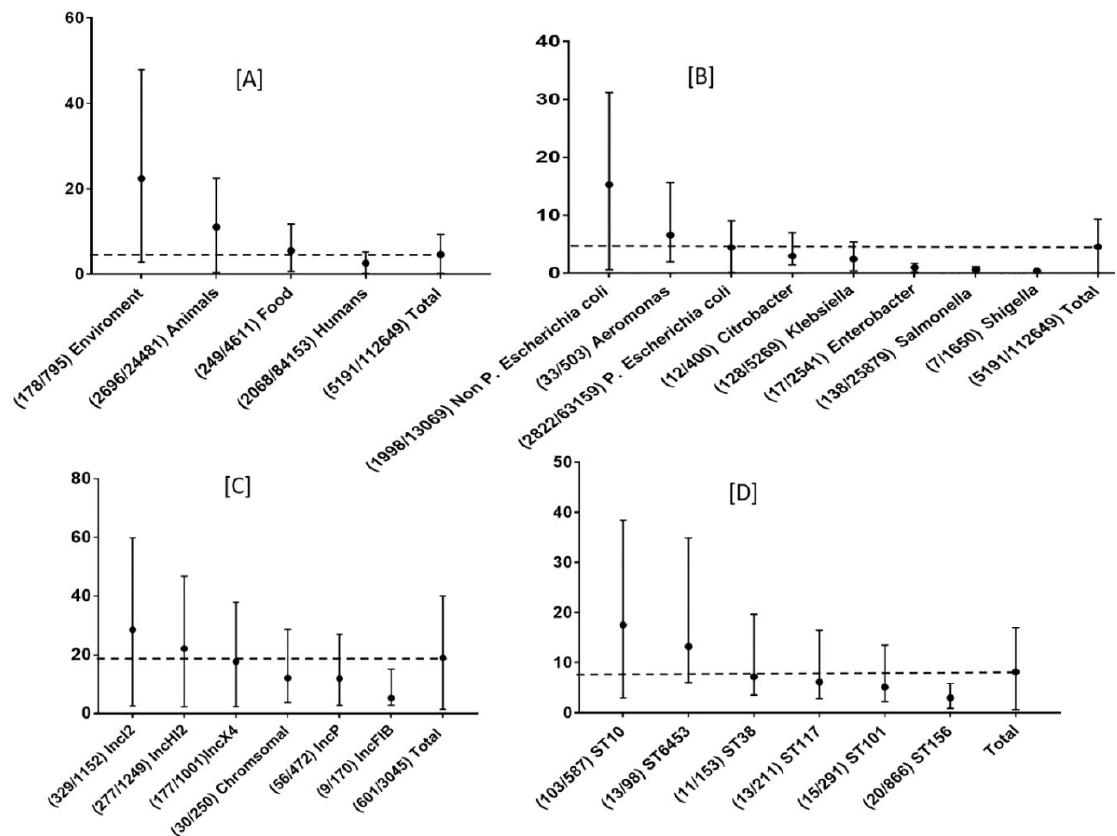
Figure 3. Prevalence of mcr genes from multiple sources ( A ), bacteria ( B ), plasmids ( C ) and pathogenic E. coli sequence type (ST) ( D ). *( ) contain the positive strains/total strains *Values in ( A and B ) are the prevalence of positive strains in the total number of strains, in ( C ), the value is the prevalence of plasmid types and in ( D ) P . E. coli harboring mcr -1 shows the prevalence of different sequence types (ST) of the positive isolates.